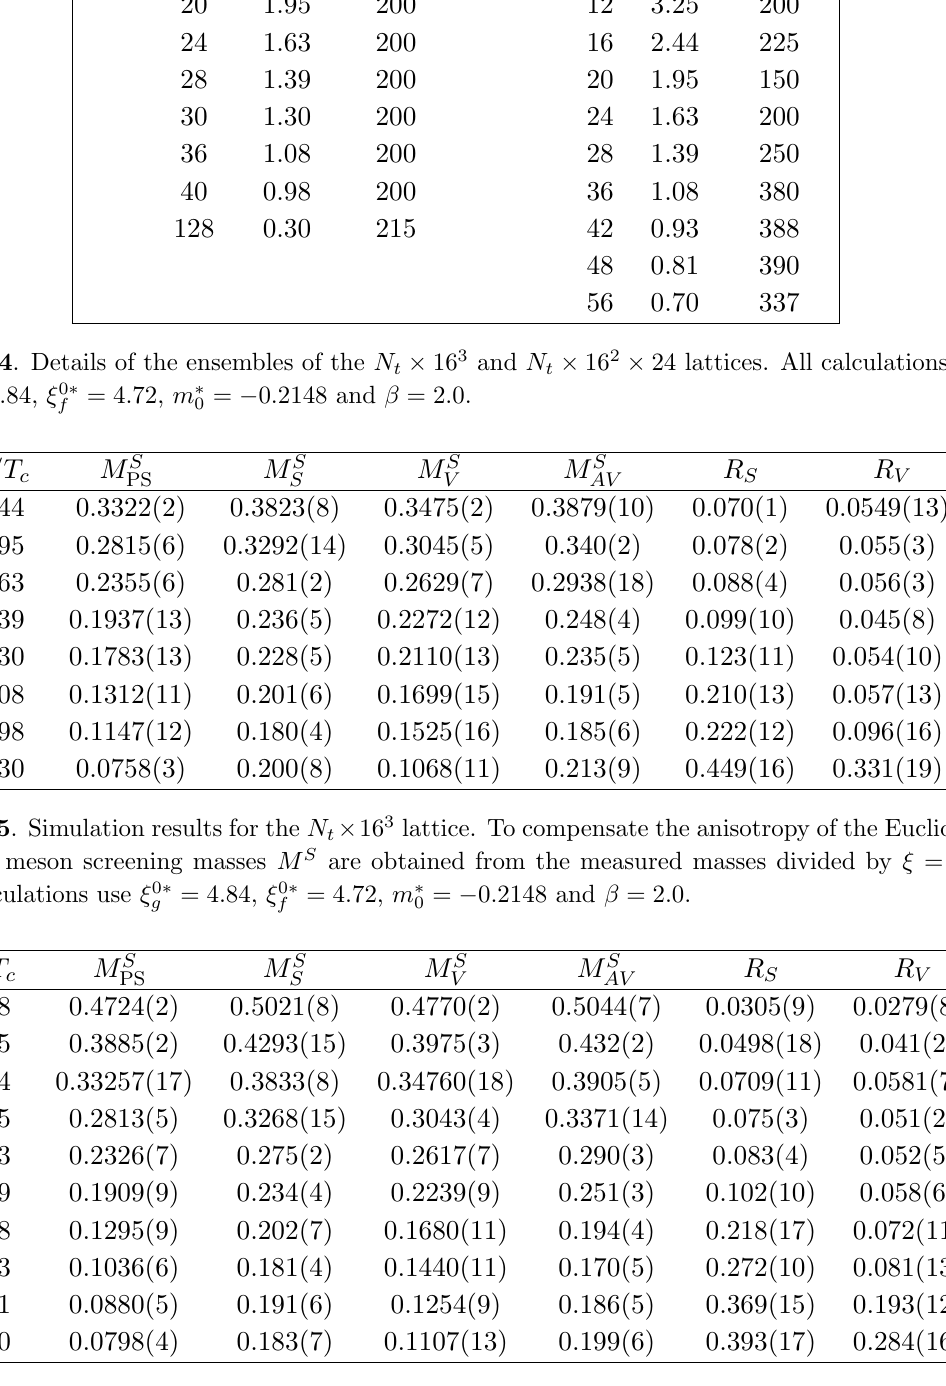
Table 6 . Simulation results for a N t (cid:2) 16 2 (cid:2) 24 lattice. To compensate the anisotropy of the Euclidean lattice, meson screening masses M S are obtained from the measured masses divided by (cid:24) = 6 : 3. All calculations use (cid:24) 0 (cid:3) = 4 : 84, (cid:24) 0 (cid:3) = 4 : 72, m (cid:3) = (cid:0) 0 : 2148 and (cid:12) = 2 : g 0 f